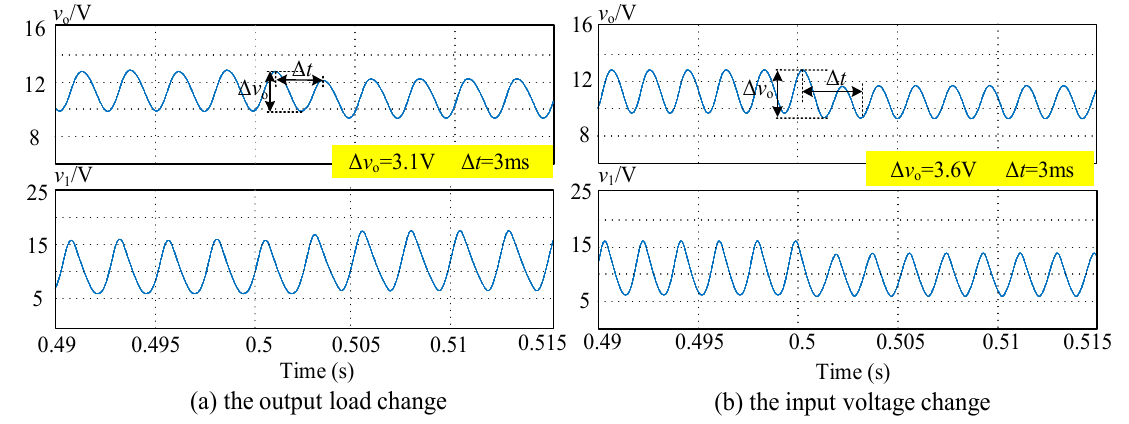
Figure 9. Waveforms of v 1 and v o under the traditional PT control when the output load and input voltage changes.